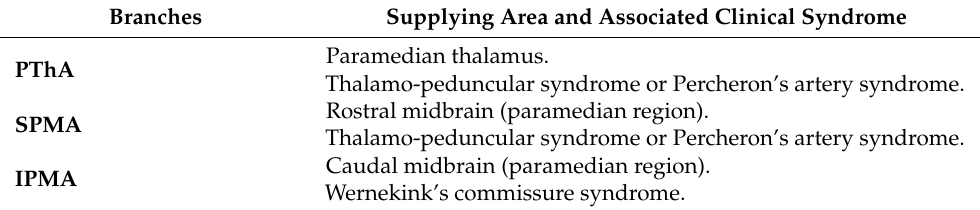
Table 6. Perforating branches of the interpeduncular